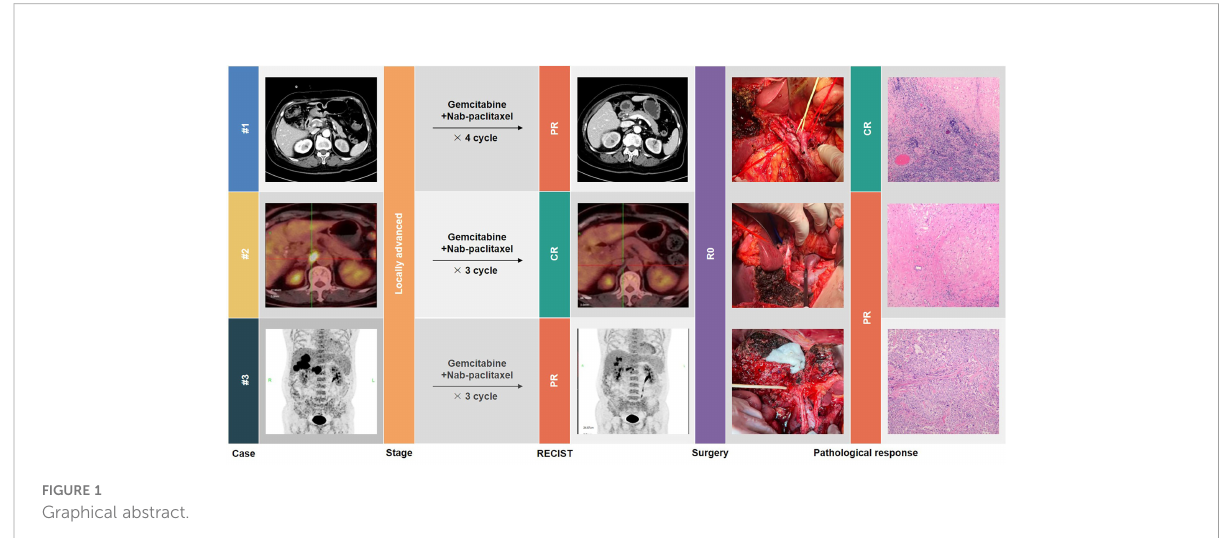
FIGURE 1 Graphical